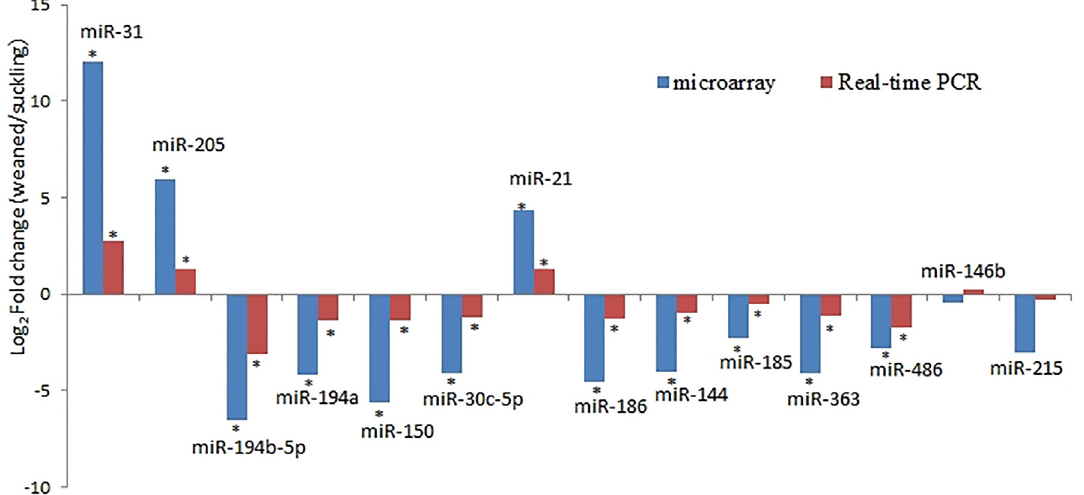
Fig 2. Validation of microarray results by RT qPCR. Four biological replicates were used, and U6 snRNA was used as an internal control. Means with the star on the column differ significantly (P < 0.01 for microarray; P < 0.05 for RT qPCR).